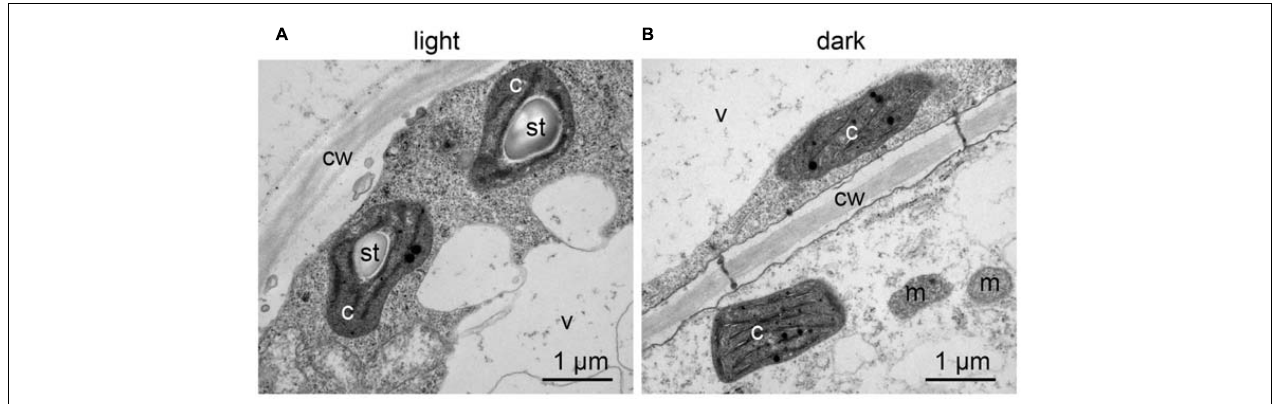
FIGURE 4 | Transitory starch accumulation in Arabidopsis photosynthetic cell cultures during the light/dark cycle. TEM observations were carried out: (A) at the end of the 16 h light phase; (B) at the end of the 8 h dark phase. c, chloroplasts; cw, cell wall; m, mitochondria; st, starch; v, vacuole.